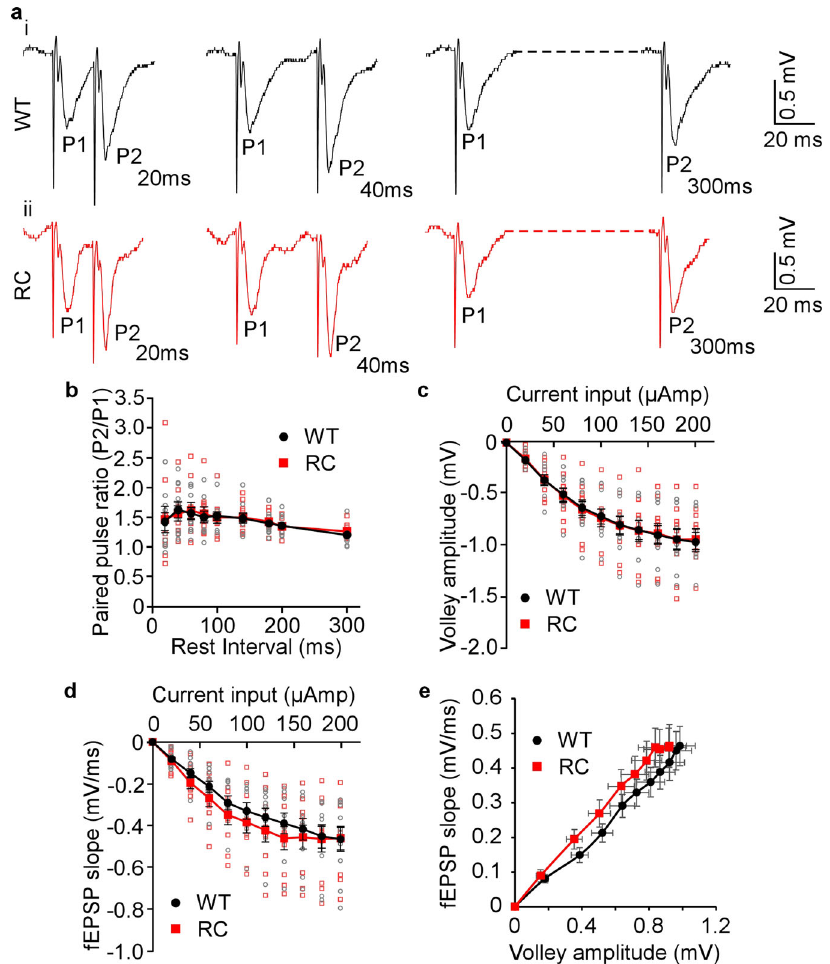
Fig. 8 CPVT RyR2 mutation R4496C + / − has no signi fi cant effect on presynaptic short-term facilitation. Representative traces of paired pulse recordings in Schaffer collaterals in dorsal hippocampal slices from RyR2 WT ( a i) and RyR2-R4496C + / − (RC) mutant ( a ii) mice (3 – 4 months old). Stimulus input current for Schaffer collaterals was 60 µ A. The relationship between paired pulse ratio and rest interval in WT and R4496C + / − mutant brain slices is shown in b . Note that there are no signi fi cant differences in the amplitude of fi ber volleys ( c ), or in the fEPSP slopes in relation to the current input ( d ), or fi ber volley amplitude against the fEPSP slope ( e ) between the WT and RyR2 R4496C + / − mutant brain slices. Data shown are mean ± SEM ( n = 10 slices from 8 WT and 7 RC the RyR2 R4496C + / − mutation on presynaptic short-term plas-